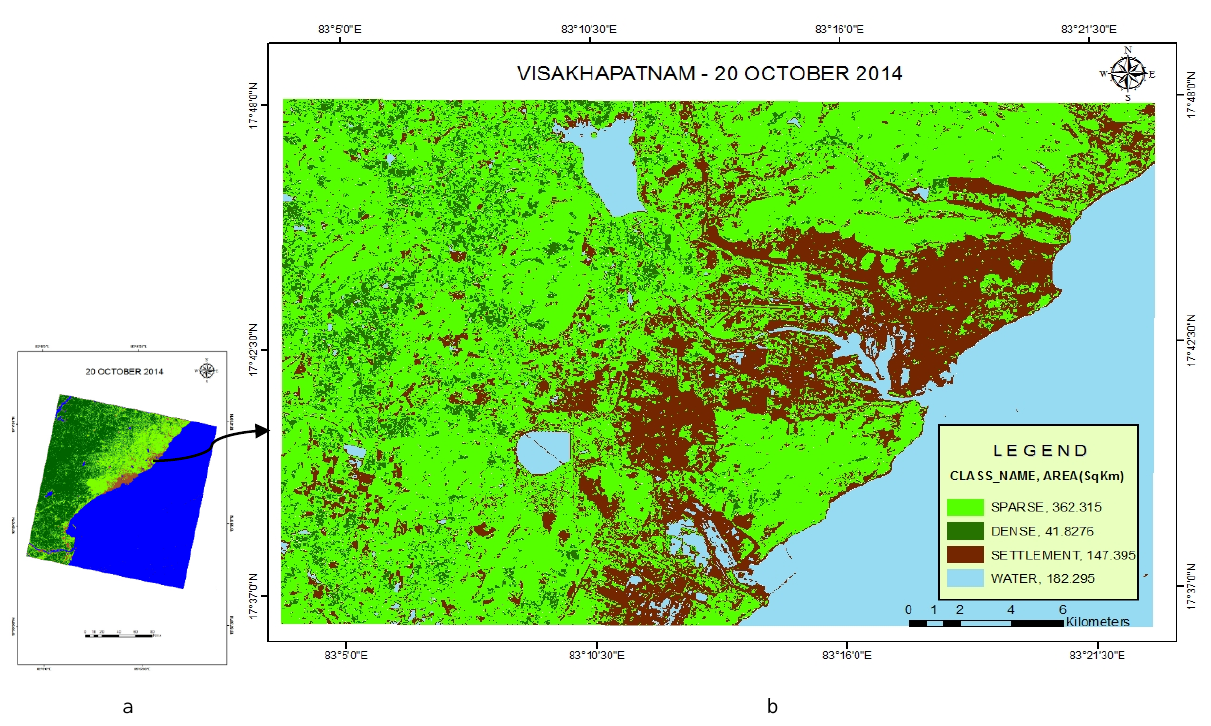
Figure 7. (a) NDVI classification map (b) Study area is clipped from the NDVI classification map